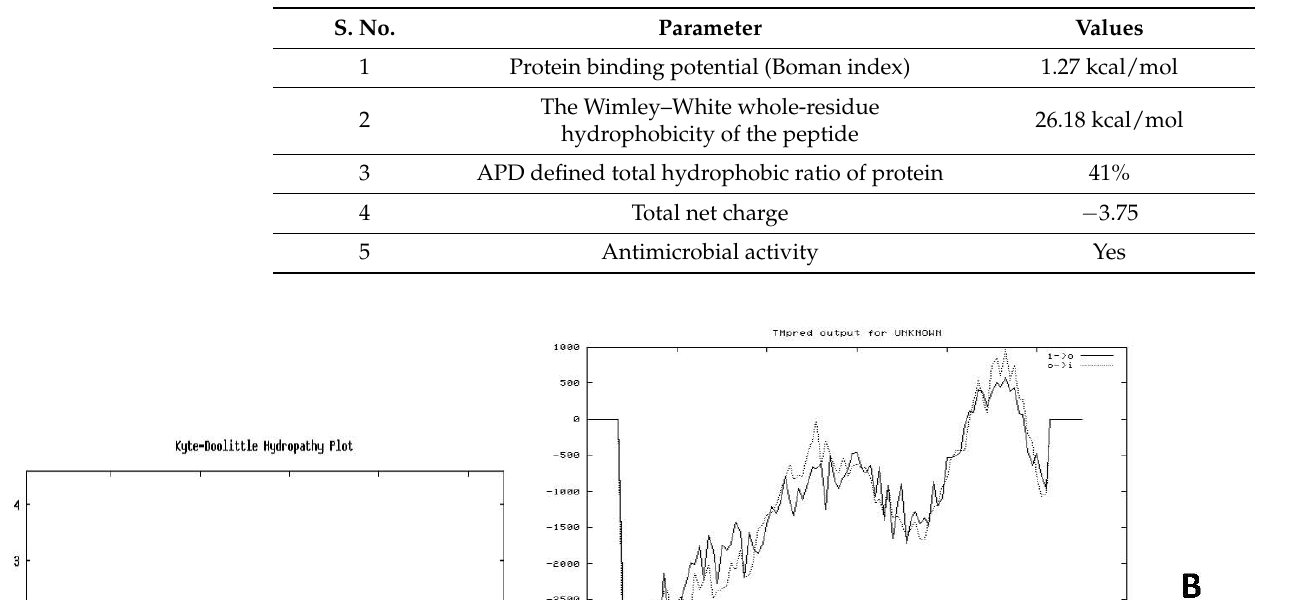
Table 2. List of various parameters of Bg_9562 predicted using Antimicrobial Peptide Database (APD)-based prediction.